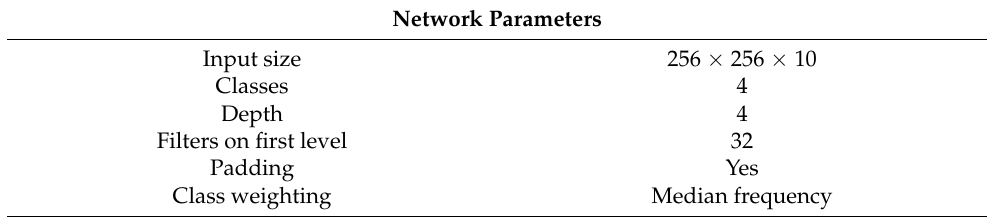
Table 18. Network parameters for UNet with simplified classes on UOS2.